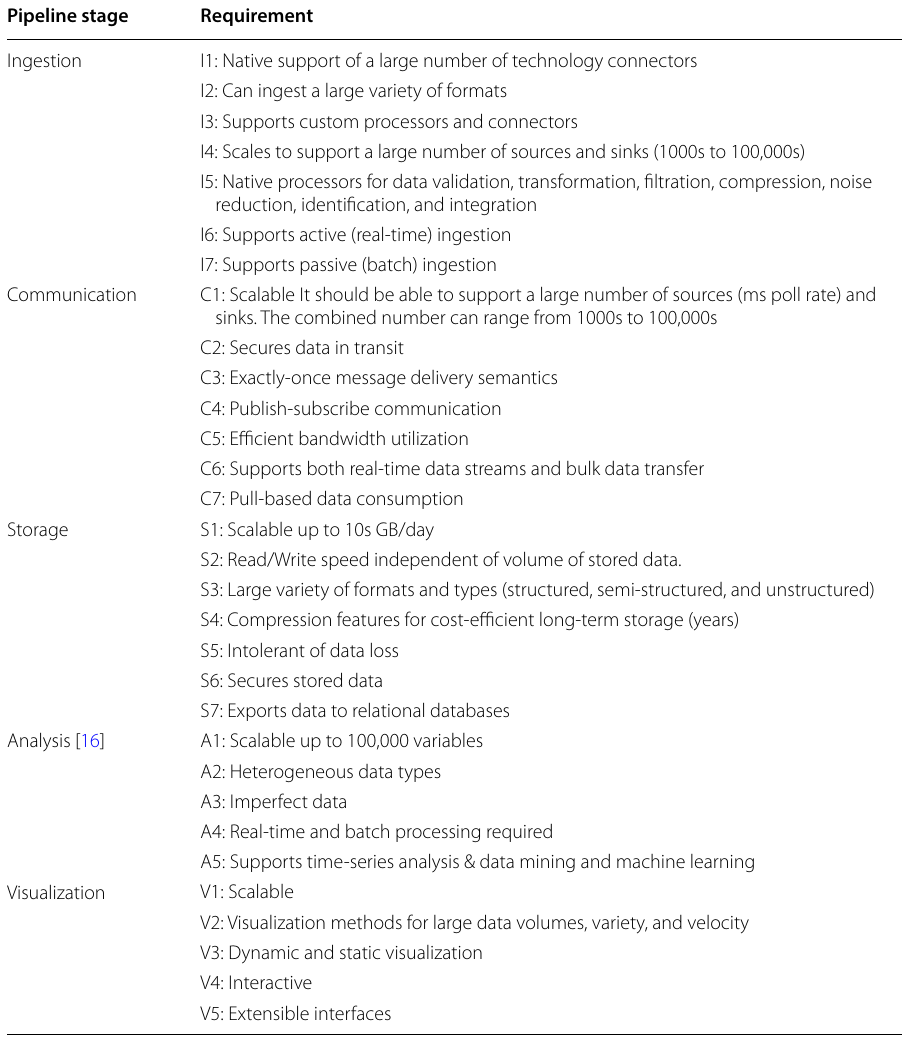
Table 2 Platform requirements by function Pipeline